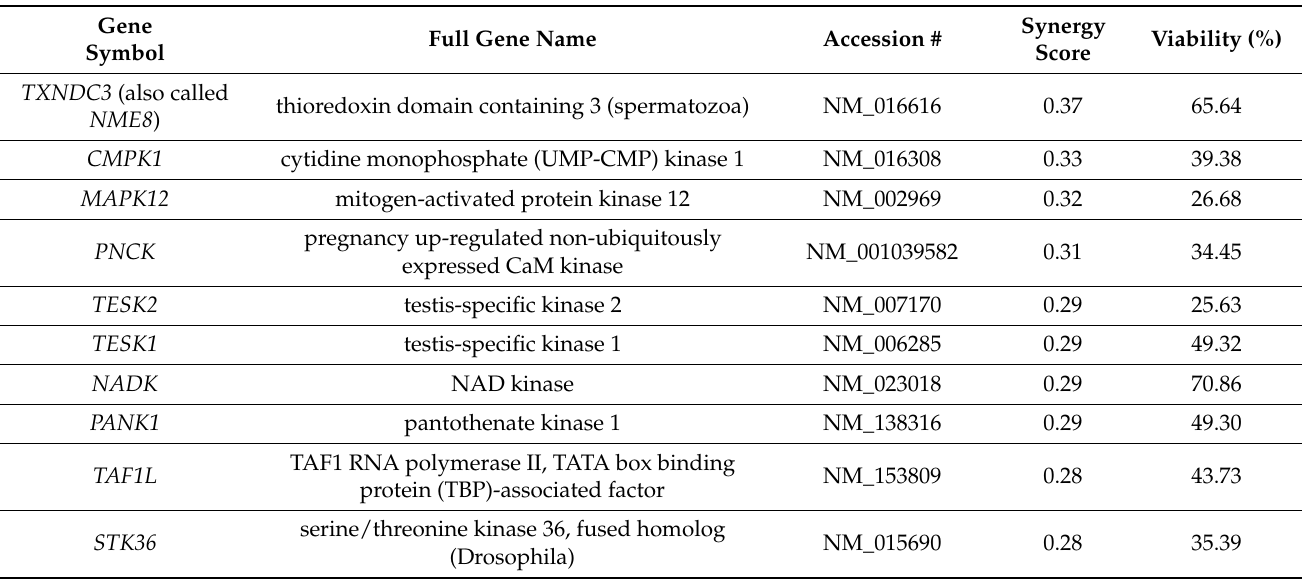
Table 1. Top 135 genes showing synergistic anti-proliferation effect with eribulin (sensitivity index cutoff